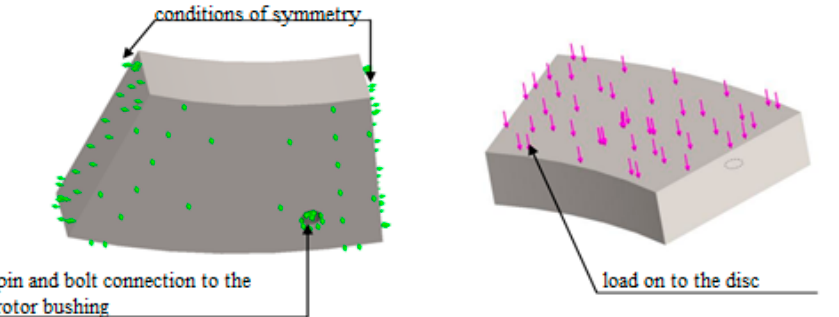
Figure 7. Acting load on the mirror surface of the disc.